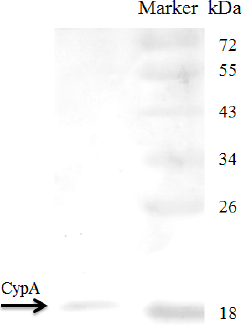
Figure 1. Result of CypA in the skin mucus detected by Western blot. Anti-CypA antibody was used to detect CypA. The CypA band is marked and equal to the precise size (~18 kDa) of the marker.